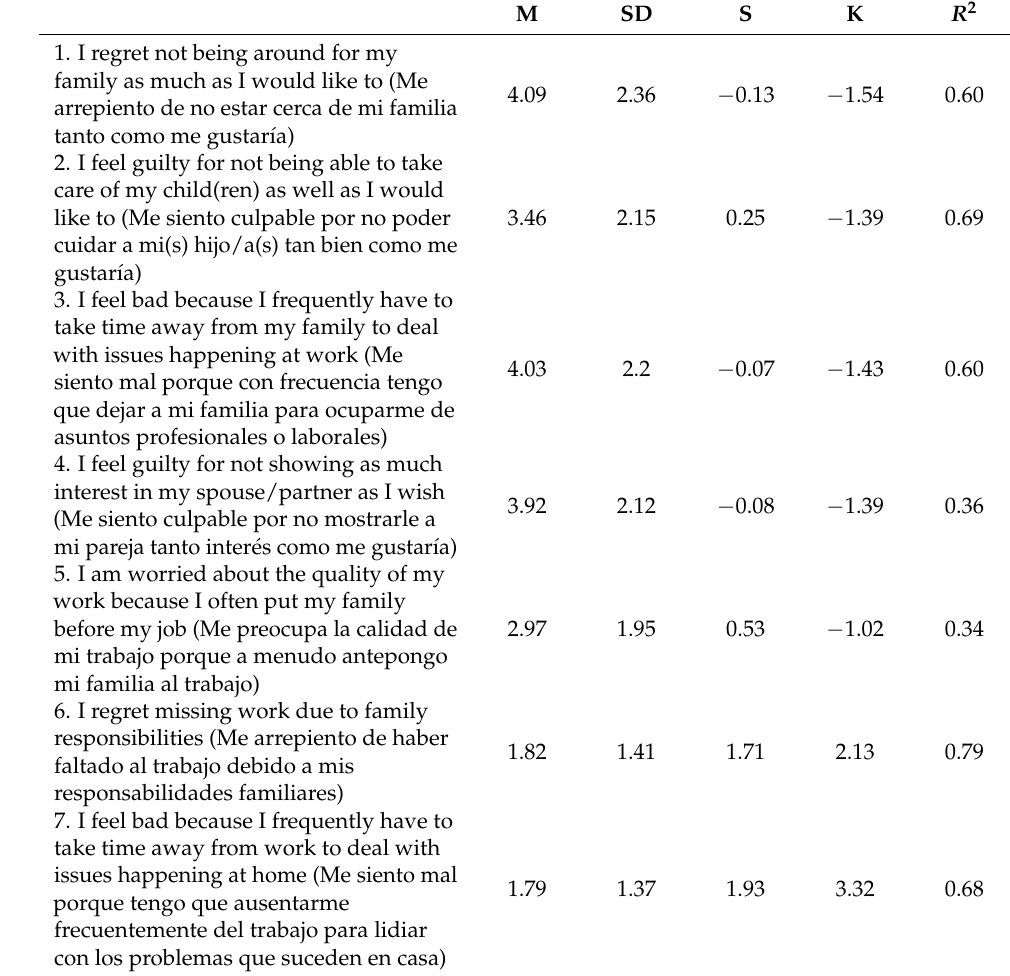
Table 1. English and Spanish items of WFGS, descriptive statistics, and standardized factor loadings of AFC ( R 2 ).